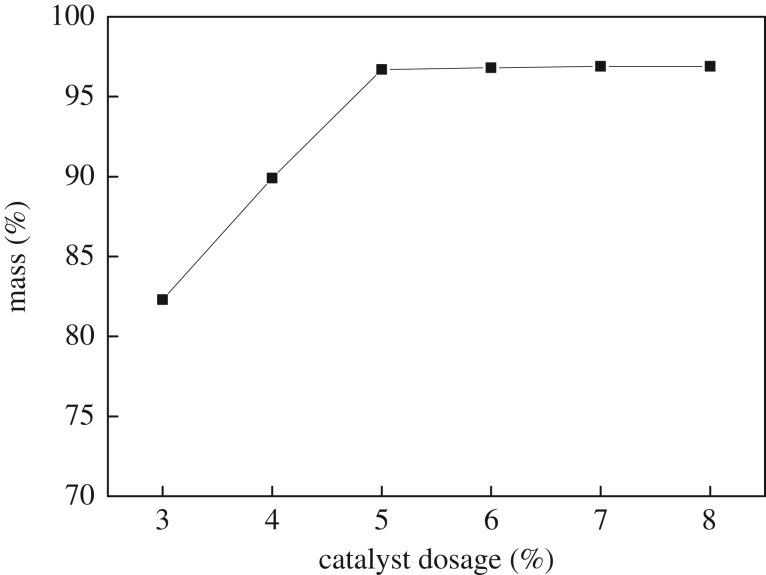
Effect of [C3SO3Hnmp]HSO4 dosage on the yield of n-butyl butyrate.